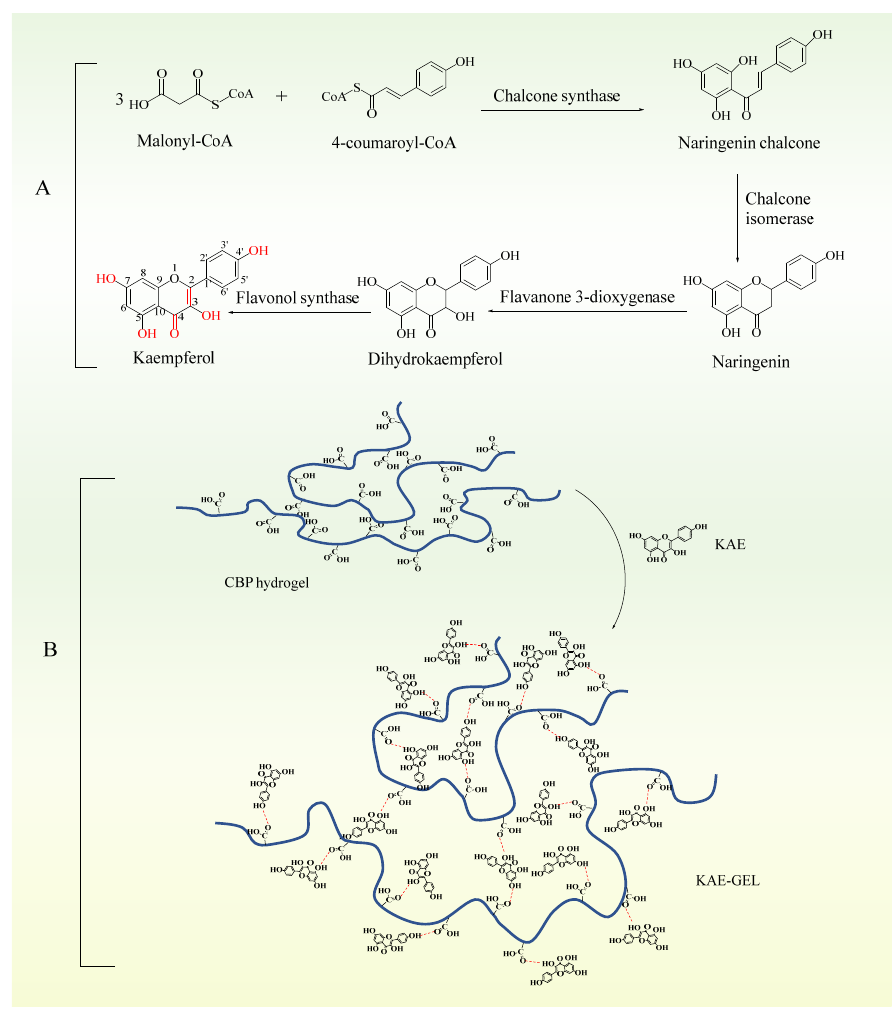
Figure 3. ( A ) Chemical and structural analysis of KAE. ( B ) Formation of KAE-GEL.